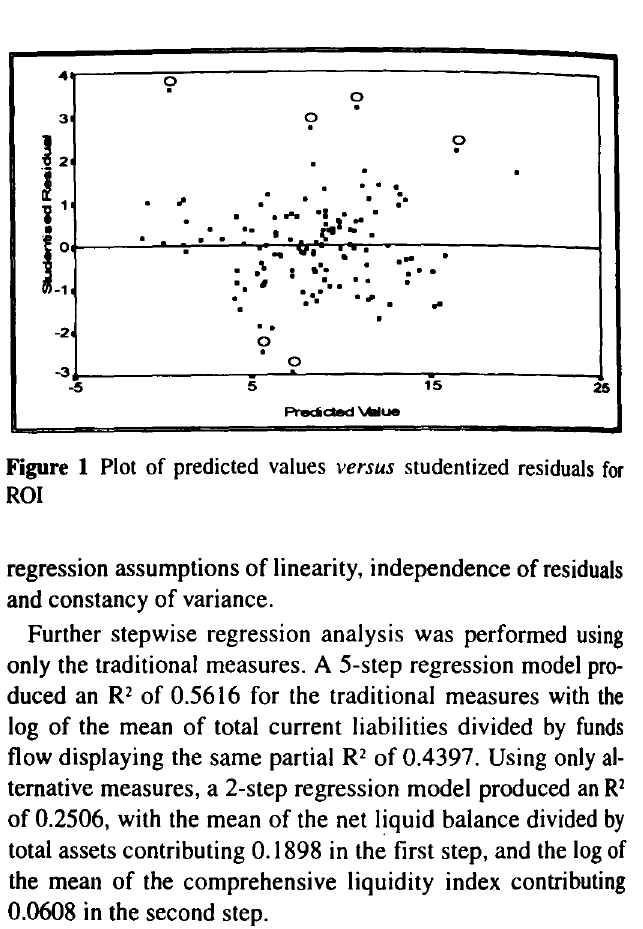
Figure 1 Plot of predicted values versus studentized residuals for ROI regression assumptions of linearity, independence of residuals and constancy of